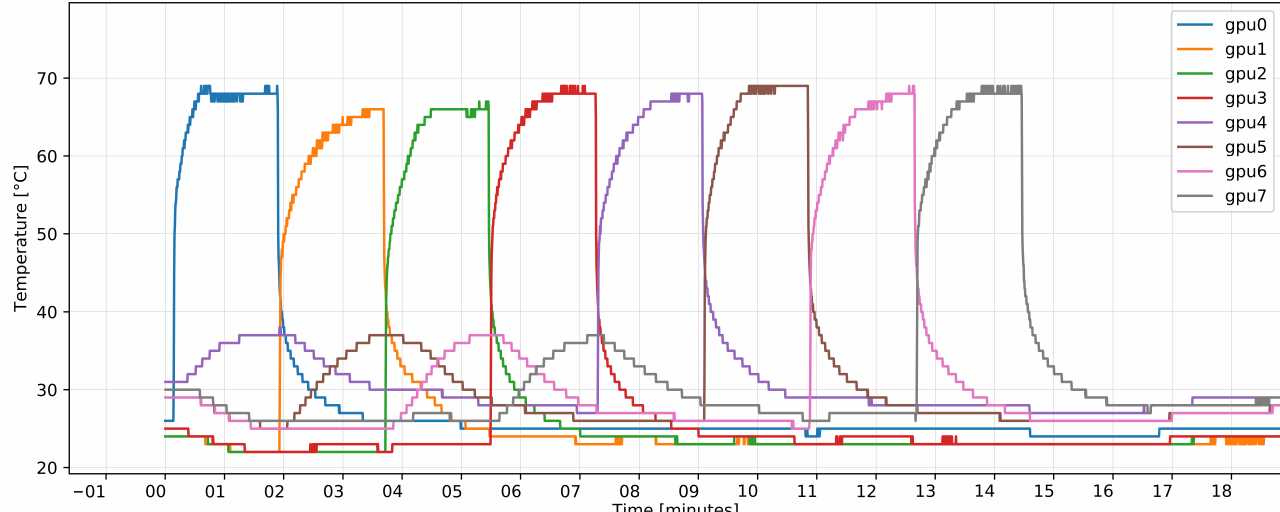
Figure 6. Temperature of the 8 GPUs in the DGX-A100 when fully loaded with half2 benchmark one after another. A GPU in the first row (0, 1, 2, 3) increases also temperature of the GPU located directly behind it in the second row (4, 5, 6, 7). When a GPU in the second row is loaded it does not influence the temperature of any GPU in the first row.